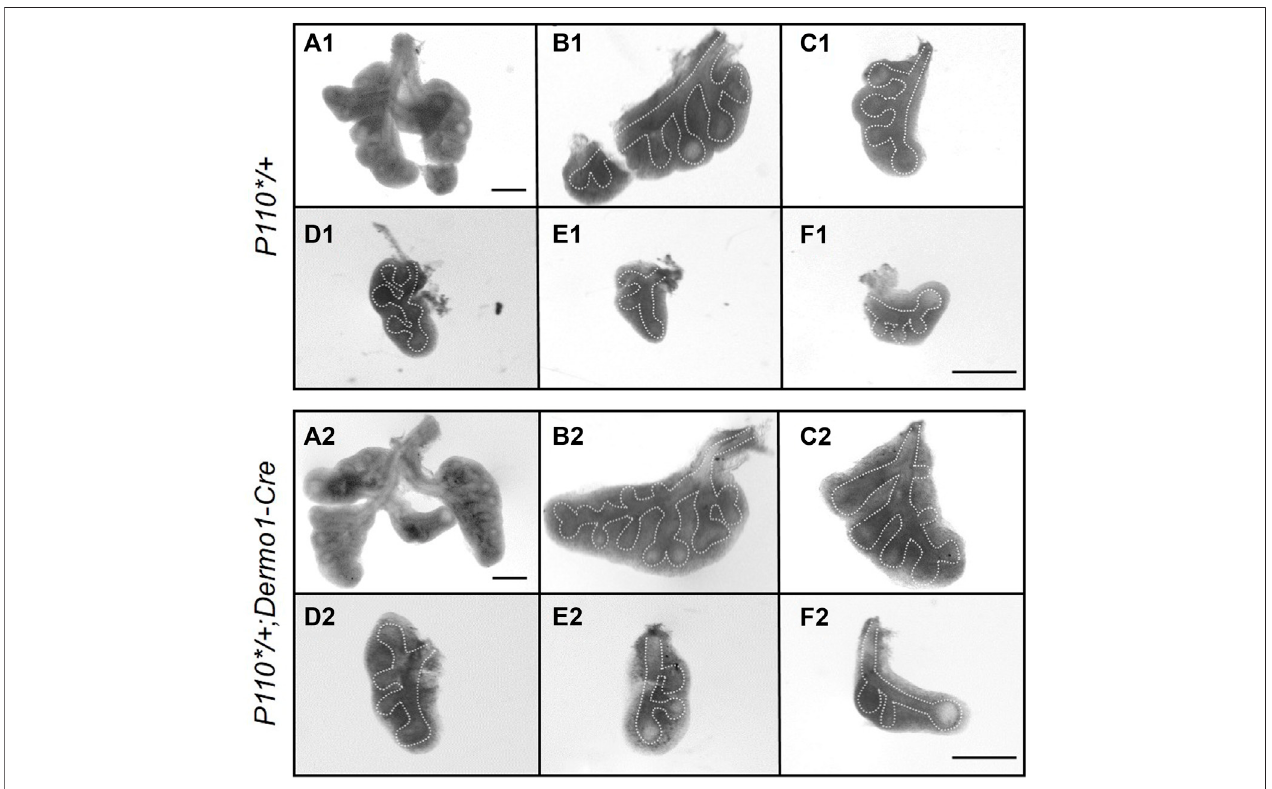
FIGURE2| Activationofp110 α promotesanearlybifurcationofembryoniclungs.Wholelungandindividuallobesofcontroland P110*/+;Dermo1-cre lungs.Scale bar: 50 μ m.